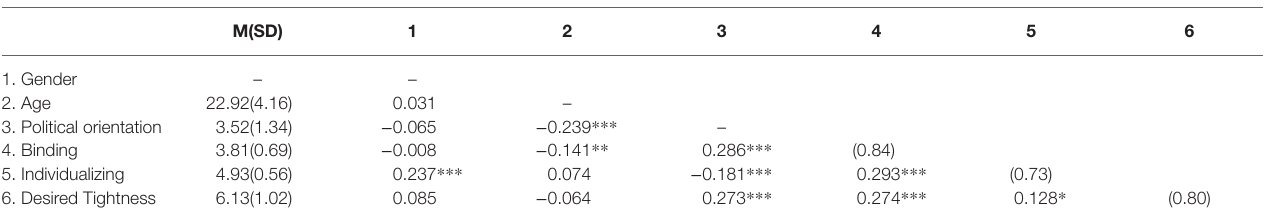
TABLE 1 | Summary of means, standard deviations, and correlations between variables, Study 1.